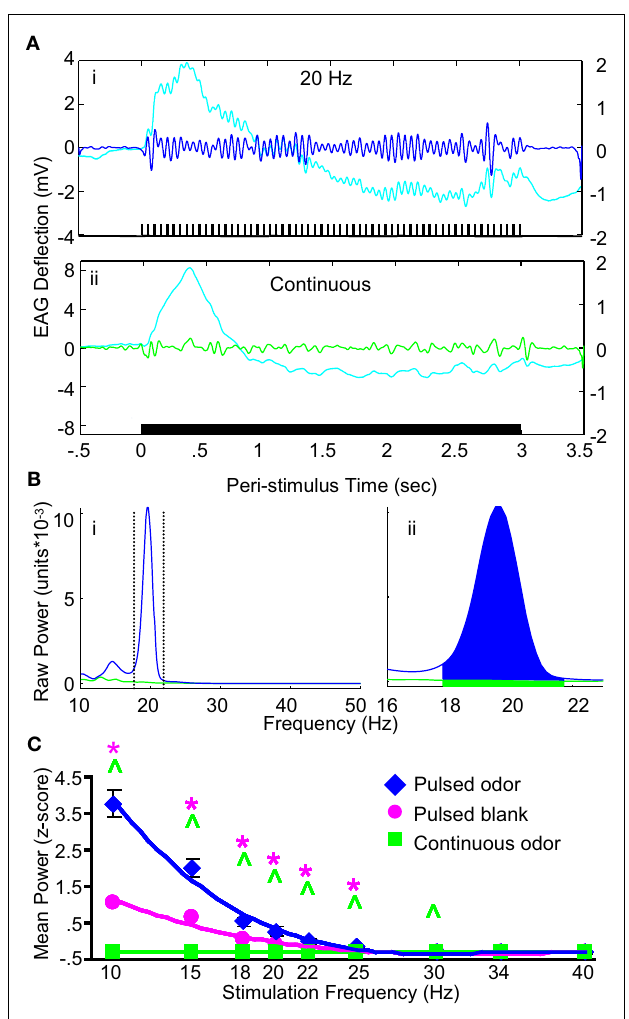
FIGURE 2 | Electroantennogram responses to pulsed odor. (A) Antennal nerve responses to periodic (i) versus continuous ( ii ) olfactory input. Stimulus representations are shown at the bottom of each panel. Unfi ltered EAG voltage trace (cyan; left Y -axis) shows a slow wave response to both 20 Hz and continuous stimuli. High pass fi ltering (5 Hz) unmasks superimposed oscillations in the response to the pulsed, but not the continuous stimulus (blue/green; right Y -axis). (B) Power spectral density of pulsed (blue) and continuous (green) voltage traces show 20-Hz oscillations in the response to the pulsed stimulus. Dotted lines (i) highlight a 4-Hz region around the pulse stimulus frequency. ( ii ) This 4-Hz band around the input frequency was integrated to obtain total power value for both pulsed and continuous responses. Note that the pulsed area includes the continuous area as well. (C) Mean integrated EAG power as a function of frequency for pulsed odor (blue diamonds), pulsed blank (pink circles), and continuous odor stimulation (green squares). 3rd order trend lines are shown in the respective colors. Results are based on z -score normalized integrated power and error bars indicate SEM. At each frequency, signifi cant differences between periodic responses of pulsed odor and pulsed blank are indicated by a pink asterisk; signifi cant differences between pulsed odor and continuous odor responses are indicated by a green caret (both: t -test; p <